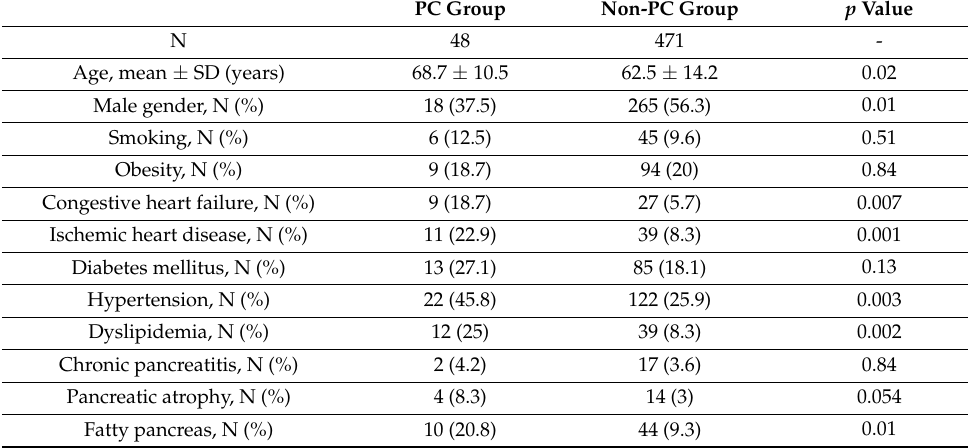
Table 1. Demographics and baseline